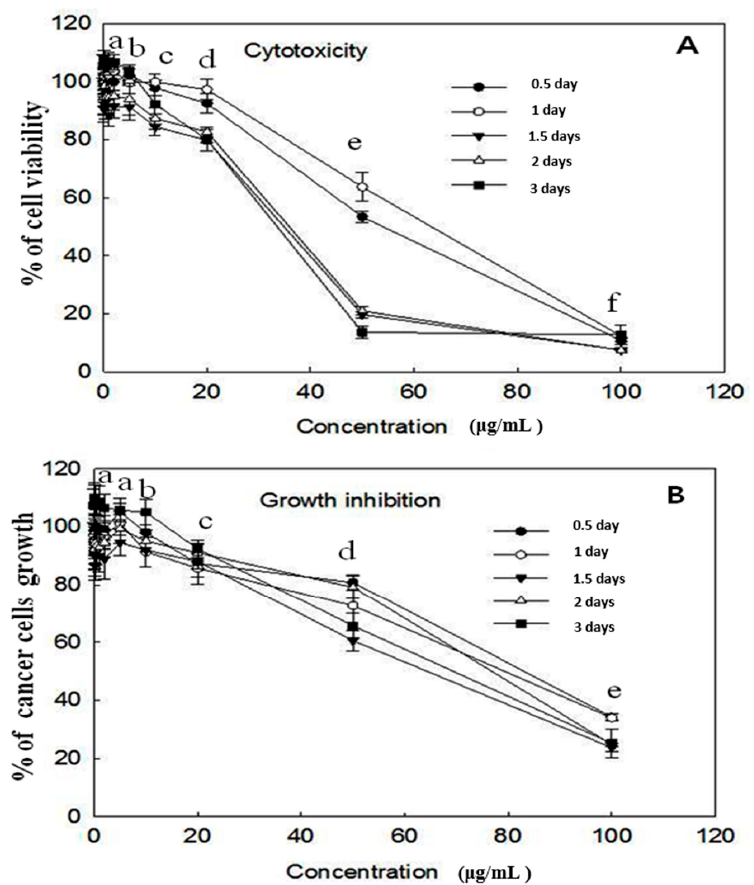
Figure 1. ( A ) Cytotoxicity effect of 1,3-BPMU on HEP-G2 hepatoma cells. The cells were treated with different concentrations of 1,3-BPMU in 10% FBS-DMEM and incubated for 0.5, 1.0, 1.5, 2.0 and 3 days at 37 °C. The maximum cytotoxicity was exhibited at the concentrations of 50 and 100 μ g/mL of 1,3-BPMU; ( B ) Effect of 1,3-BPMU on HEP-G2 cell growth. The cells were treated with different concentrations of 1,3-BPMU in serum-free DMEM and incubated for 0.5, 1.0, 1.5, 2.0 and 3 days at 37 °C. 1,3-BPMU exhibited a potent tumor growth inhibition at 100 μ g/mL. Different letters, a, b, c, d, e, f, within a treatment between concentrations of 1,3-BPMU indicate significant differences ( p < 0.05).